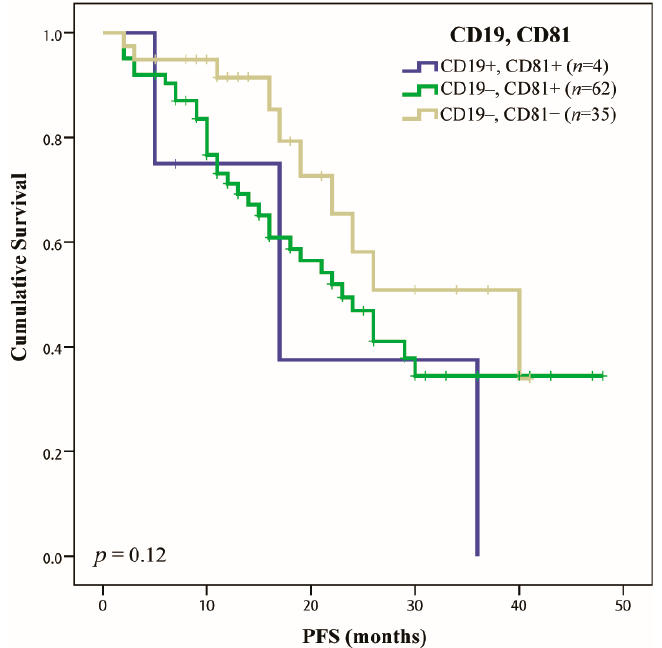
Figure A6. Multiple myeloma patients’ survival, considering the co-expression of CD19 and CD81 markers by Kaplan–Meier analysis.